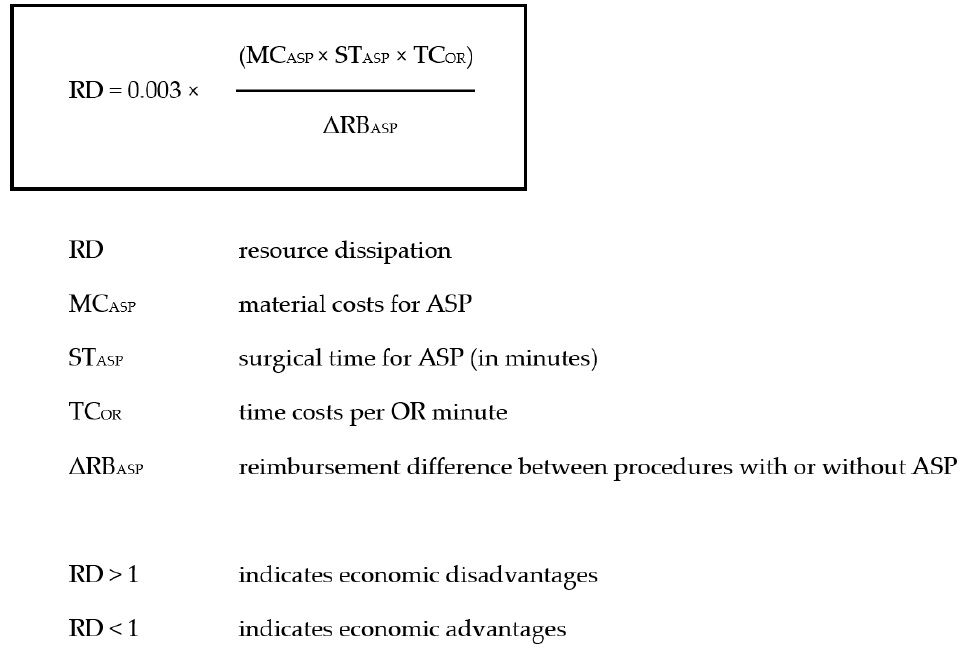
Figure 5. Mathematical formula for the decision-making process to calculate whether ASP is economically reasonable in a certain economic environment. ASP indicates additional sacroplasty.